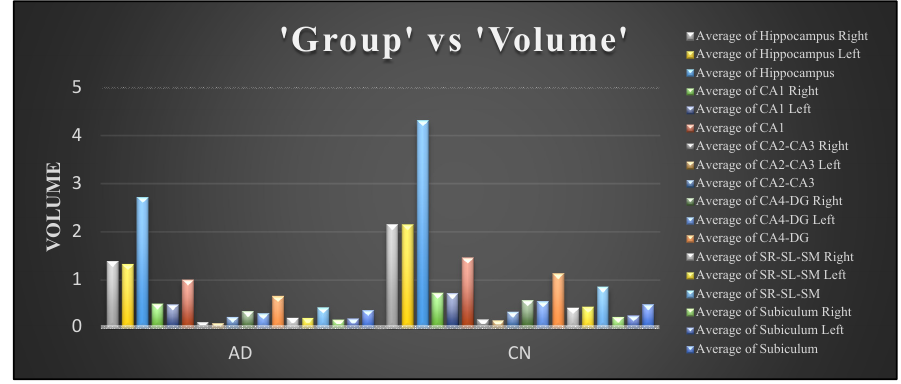
Figure 13. Comparison of volume data between AD and CN groups. In the next phase, classification models were trained only on the GLCM characteristics that had been identified. For textural features, Ensemble provided the highest accuracy (85%) at d = 1 and direction ( d , d , 0), while Decision Trees was least accurate at d = 2 in direction ( d , d , d ). One evident finding from the accuracy table is that as the GLCM distance parameter was increased, the model’s accuracy decreased since average accuracy dropped from 82.60% to 82.23% for textural features. The right and left hippocampus were exceptionally small in the MRI, and as the distance parameter was increased, the quality of the GLCM matrix decreased due to its small dimensions; hence the distance was limited to d = 2. While the model was trained with eight GLCM features, i.e., Textural data, the results produced were unsatisfactory as it had less accuracy than the results produced with Textural and Structural Data. Table 5 represents the classification accuracy with Textural and structural data as